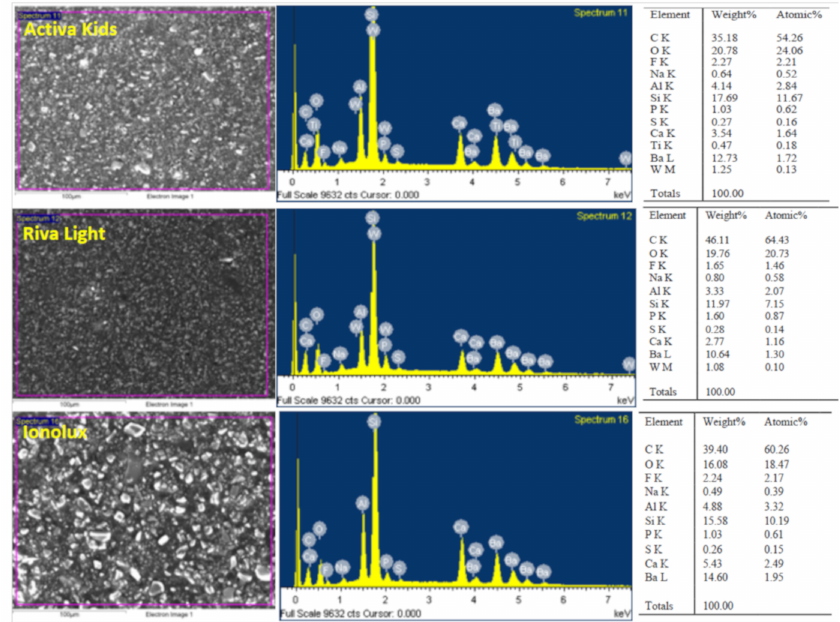
Figure 6. Surface properties and composition of Activa, Ionolux, and Riva under scanning electron microscopy (SEM) with energy-dispersive X-ray (EDX) analysis (SEM–EDX). SEM image (Left column), EDX spectra (Middle column), and table of elements (Right column). The scale bar represents 100 µ m for all